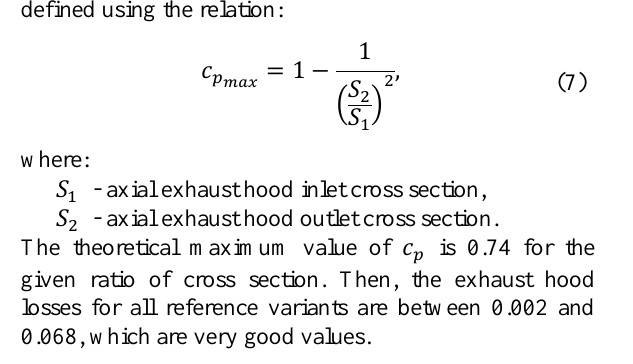
Fig. 13. Comparison of results – reference variant.